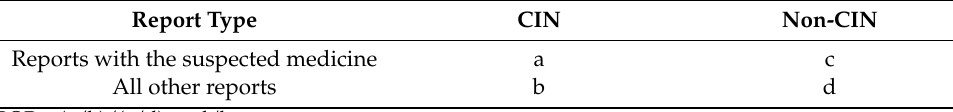
Table 4. Cross-tabulation and calculation formula for RORs of